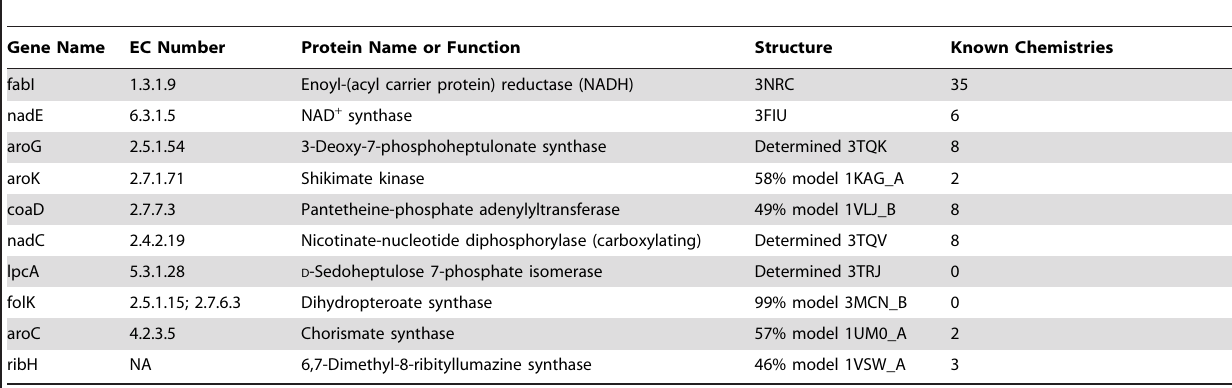
Table 2. Target selection and initial compound